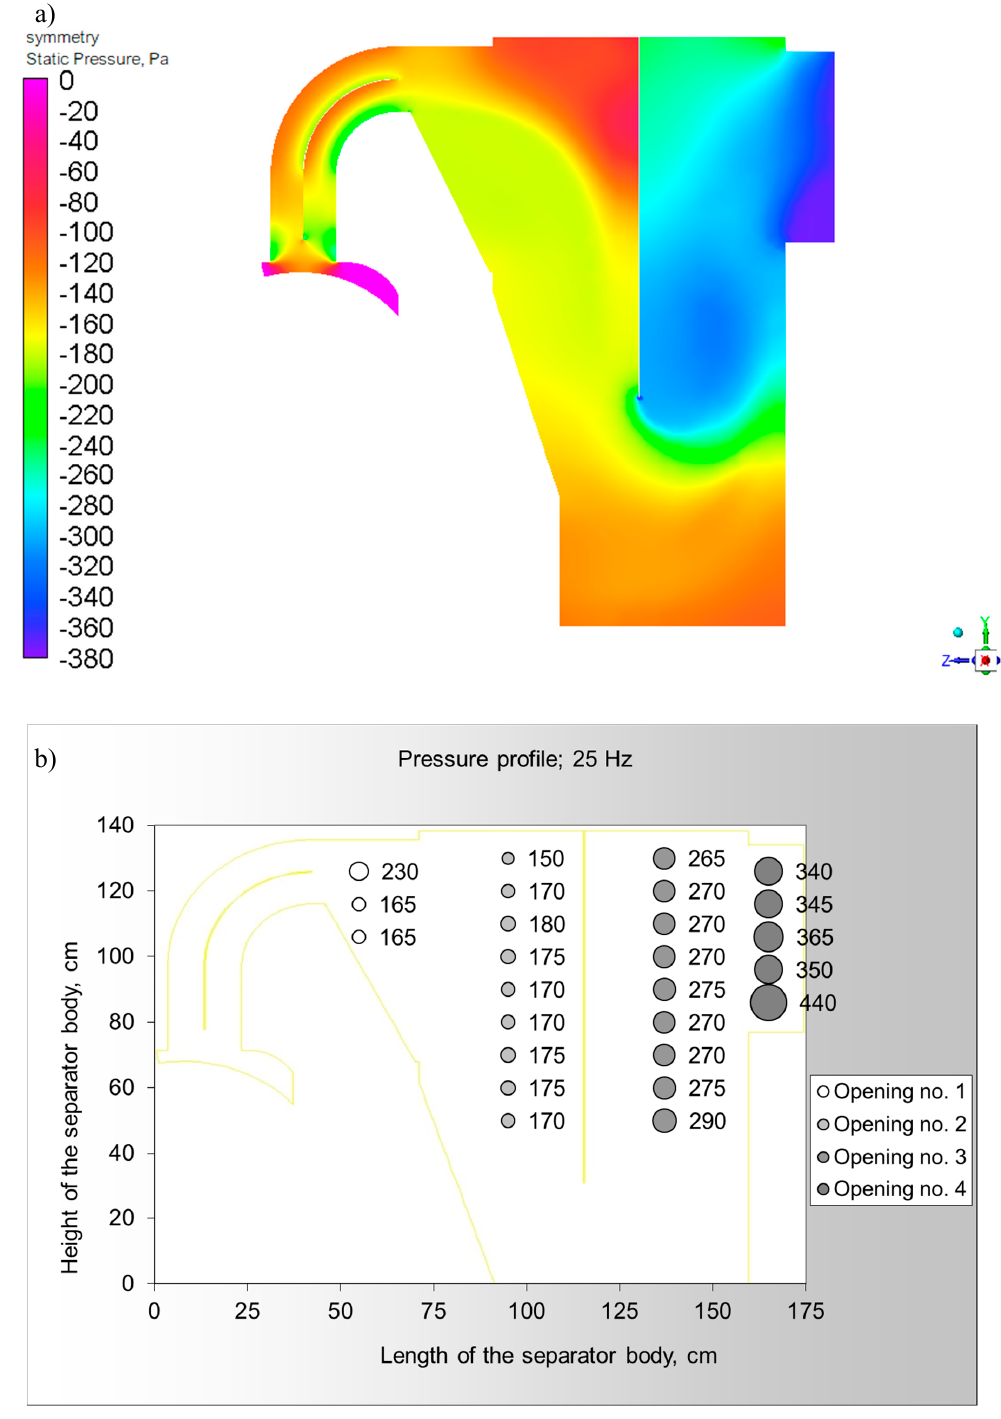
Figure A11. Pressure profile in the sorter symmetry plane (simulation of the main fan at 25 Hz): ( a ) numerical model (gauge pressure) and ( b ) measured (negative pressure).